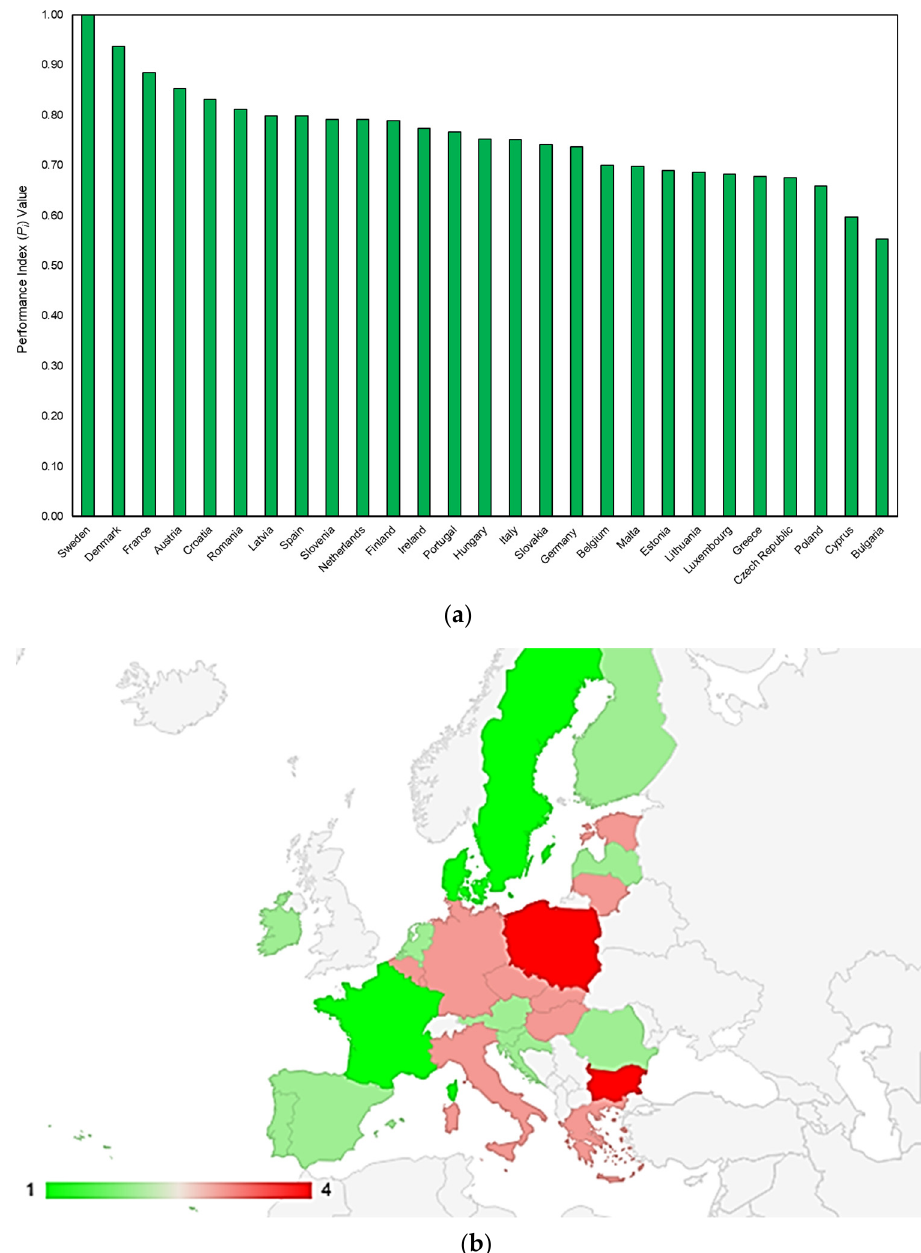
Figure 5. The average value of the P i index for individual EU-27 countries and for the entire study period ( a ) and the division of countries into similar groups ( b ).